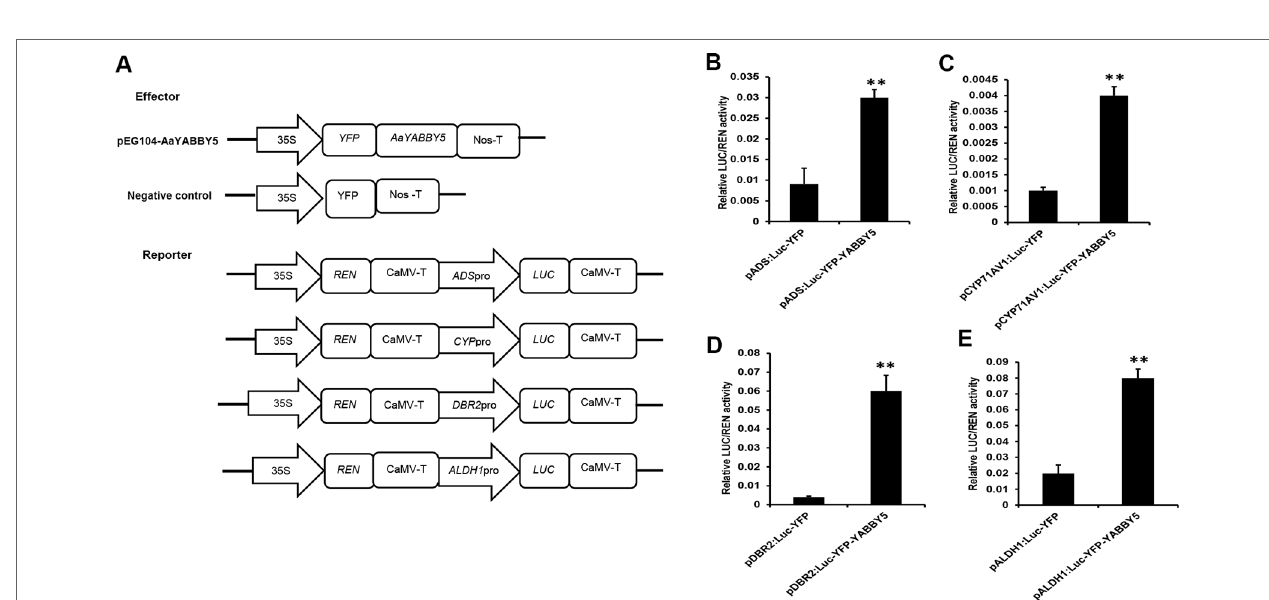
FIGURE 4 | Dual-luciferase (LUC) reporter assay. (A) The sketch map shows the constructs for dual-LUC assay. The coding sequence of AaYABBY5 was fused to the yellow fluorescent protein (YFP) present in the pEG104 vector to make the effector construct. Empty vectors were used as negative controls. Promoters of ADS , CYP71AV1 , DBR2 , and ALDH1 were fused with the N-terminal of the LUC gene for the preparation of reporter constructs. (B–E) Dual-LUC analysis was performed by transient infiltration of Nicotiana benthamiana leaves with equal concentrations of Agrobacterium GV3101 cells transformed with effector and reporter constructs, respectively. The values were obtained as a ratio of the activity of firefly luciferase and renilla luciferase. A significant increase in the activities of ADS , CYP71AV1 , DBR2 , and ALDH1 promoters was found in the presence of the AaYABBY5 effector. Data represent values obtained as mean ± SD of four independent infiltrations. Error bars represent standard deviation for n = 4. Statistical significance was performed using Student’s t -test with paired and two-tailed distribution methods. ** P <